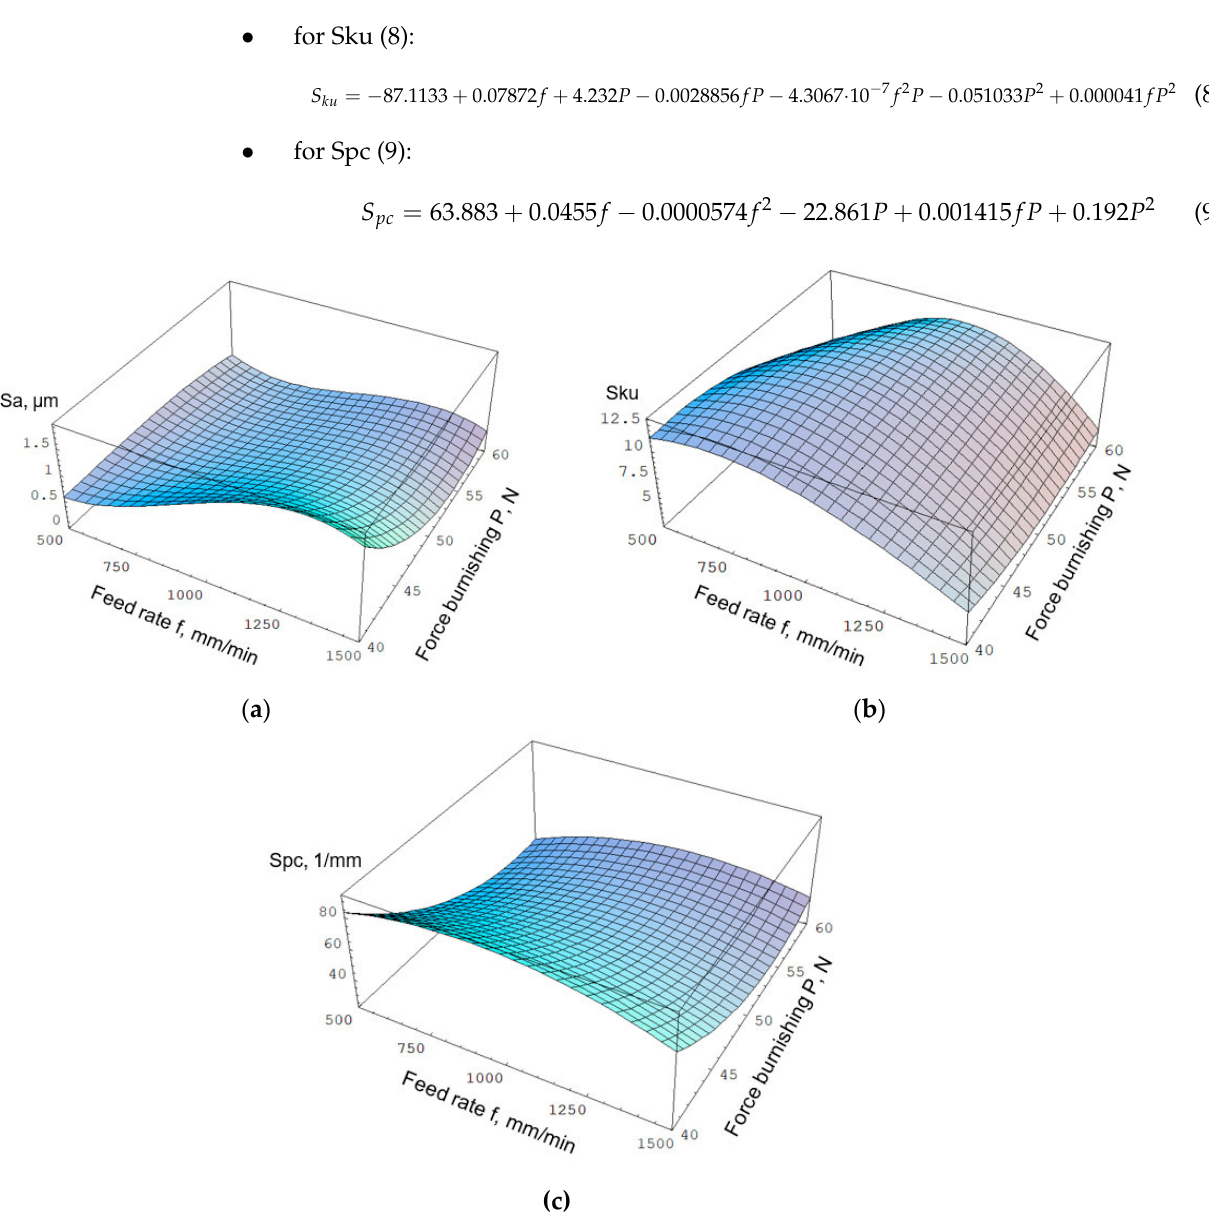
Table 9. R 2 value and p -value for individual structural elements of regression models.